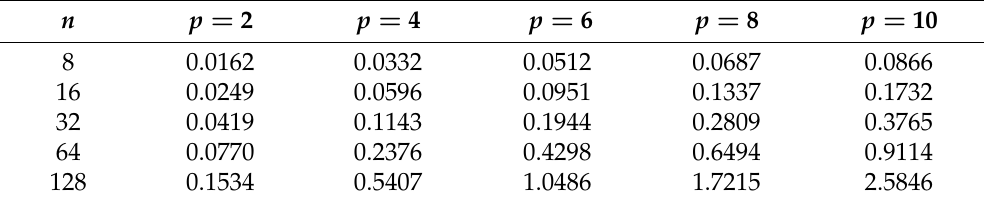
Table A6. Execution time (sec) of PDIST . EncodeY operation on Raspberry